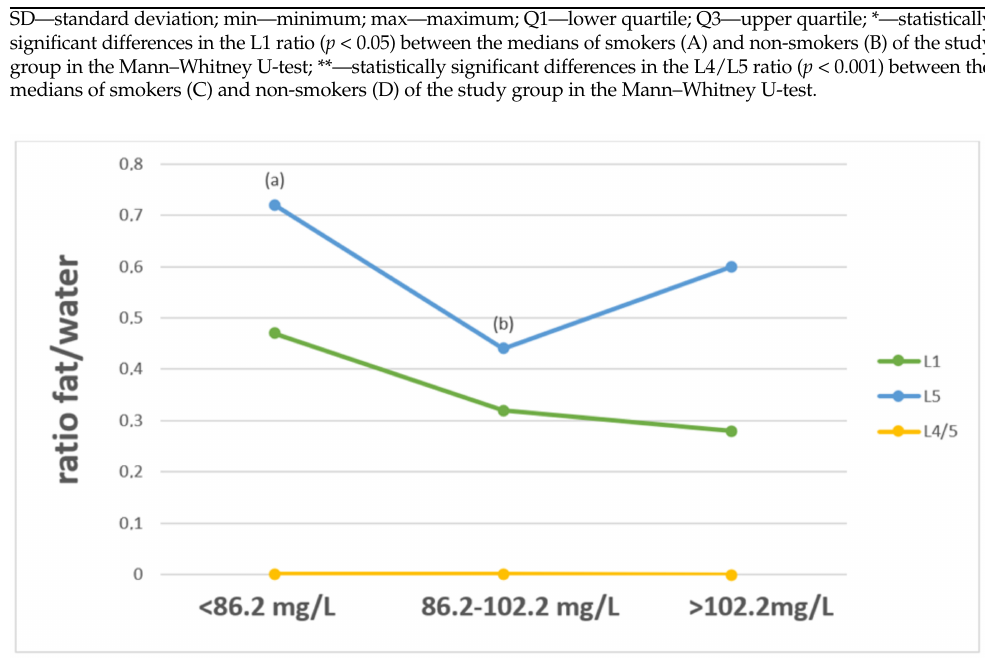
Figure 1. Fat/water ratio of selected spine structures in 1 H-MRS, divided into serum Ca concentra- tions below, within and above the norm. Significant differences ( p < 0.05) for ( a ) vs. ( b ) in the L5 vertebral